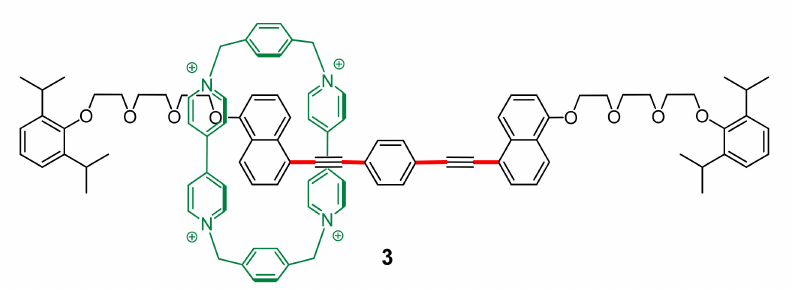
Figure 2. Fast degenerate shuttling of a cyclobis(paraquat- p -phenylene) ring along a rigid dialkyne